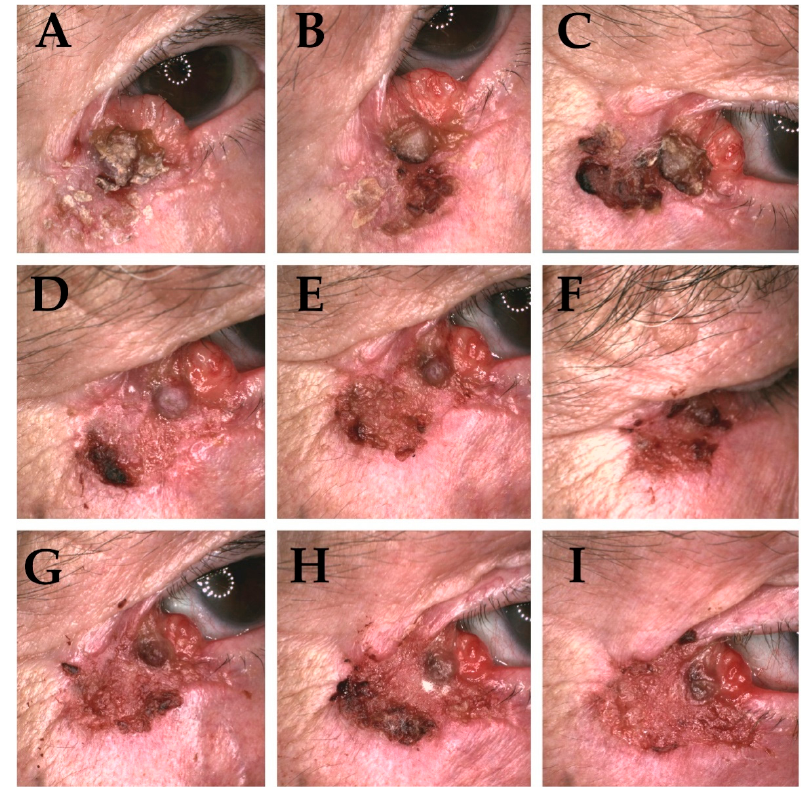
Figure 3. Clinical presentation of basal cell carcinoma of the orbital area of 95-year-old patient, infiltrating type. ( A )—Tumour prior to brachytherapy, visible—Erythematous nodule, scar-like plaque, pigmented structures, telangiectasia, short vessels, erosion, ulceration. ( B – I ) (t2–t9) During subsequent treatment fractions visible gradual vanishing of nodular structures and vessels with formation of ulceration have been noticed.